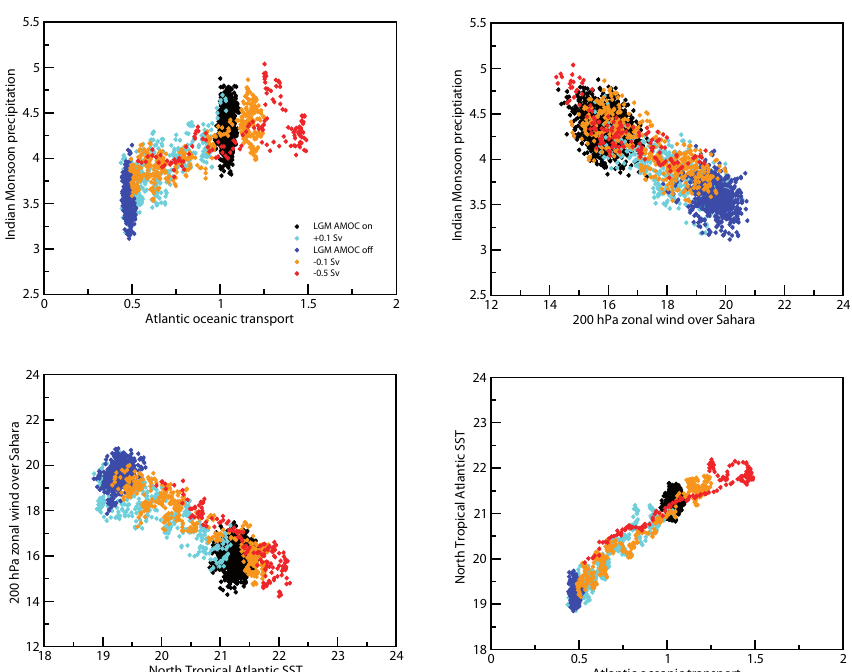
Fig. 8. (a) Yearly JJAS values of Indian monsoon precipitation (mmday − 1 ) over the region (60–80 ◦ E, 5–15 ◦ N) vs. total Atlantic oceanic northward heat transport maximum (in PW, with the maximum being searched between the equator and 25 ◦ N), (b) Indian monsoon pre- cipitation (mmday − 1 ) vs. 200hPa zonal wind (ms − 1 ) over the Sahara (15 ◦ W–45 ◦ E, 10–30 ◦ N), (c) 200hPa zonal wind over the Sahara vs. northern tropical Atlantic SST ( ◦ C) over the region (45–15 ◦ W, 10–30 ◦ N) and (d) northern tropical Atlantic SST vs. total Atlantic oceanic heat